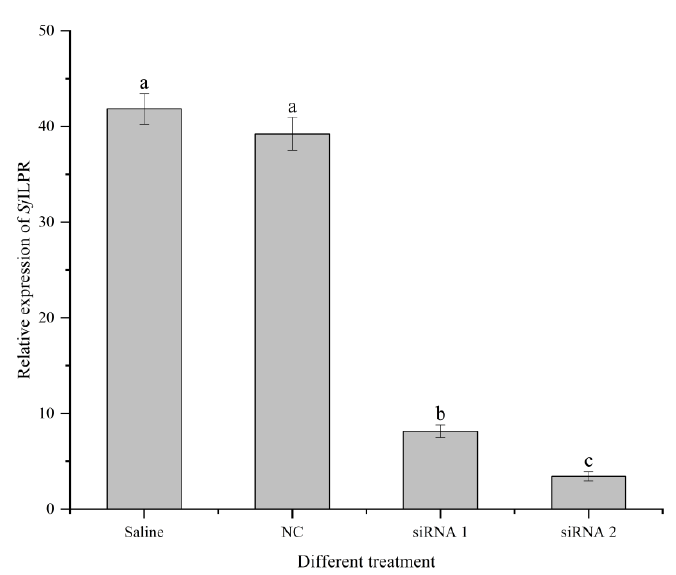
Figure 6. The expression of Sj ILPR after the silencing Sj ILPR. Relative expression of Sj ILPR was analyzed and compared between control, Saline, siRNA1, and siRNA2 groups. The results are expressed as mean ± SD (n = 8). Mean with different letters indicates significance ( p < 0.05).